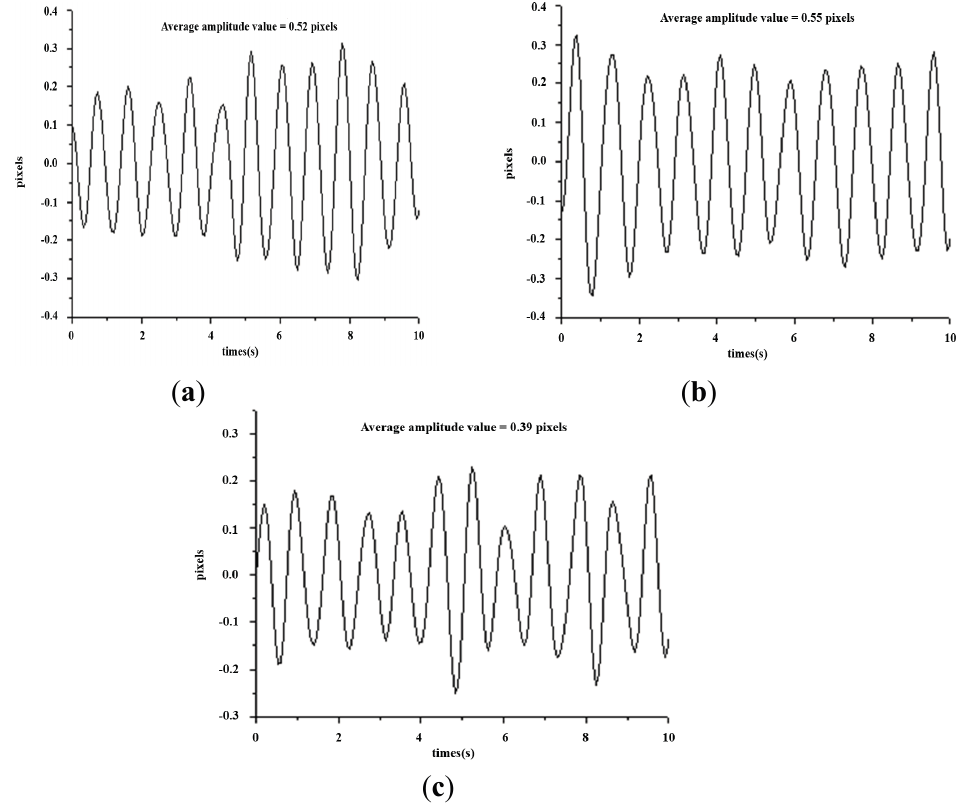
Figure 17. Band-pass filtering graph for the cun, guan and chi pulses. ( a ) Band-pass filtering graph for cun pulse; ( b ) Band-pass filtering graph for guan pulse; ( c ) Band-pass filtering graph for chi pulse.